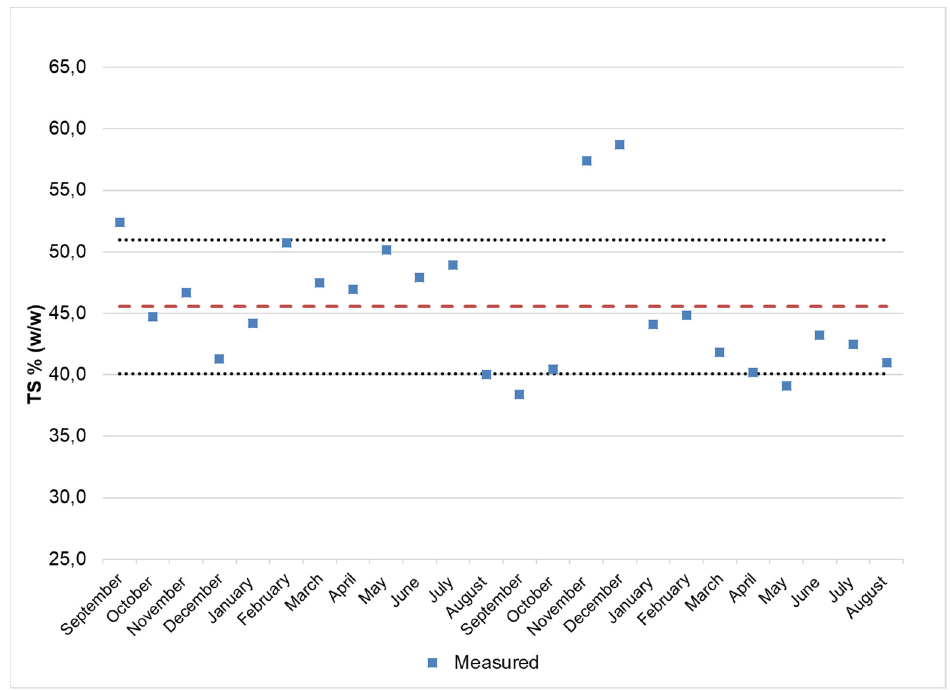
Figure 1. Annual evolution of the total solid contents of the light fraction (LF).